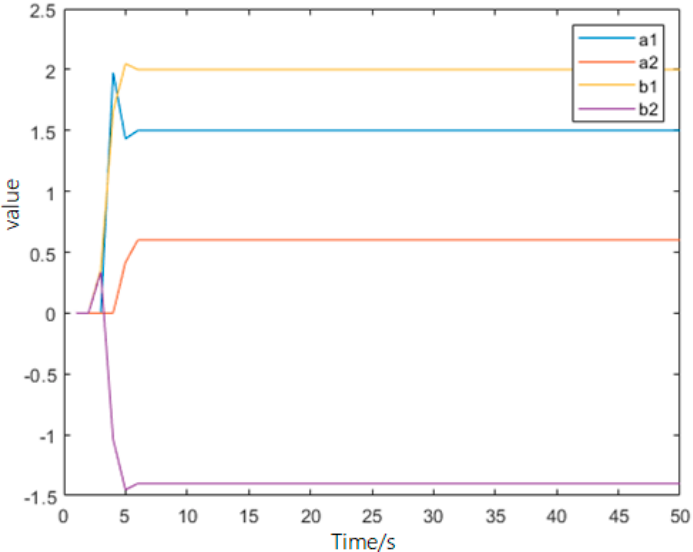
Figure 4. Parameter adaptive algorithm simulation results.